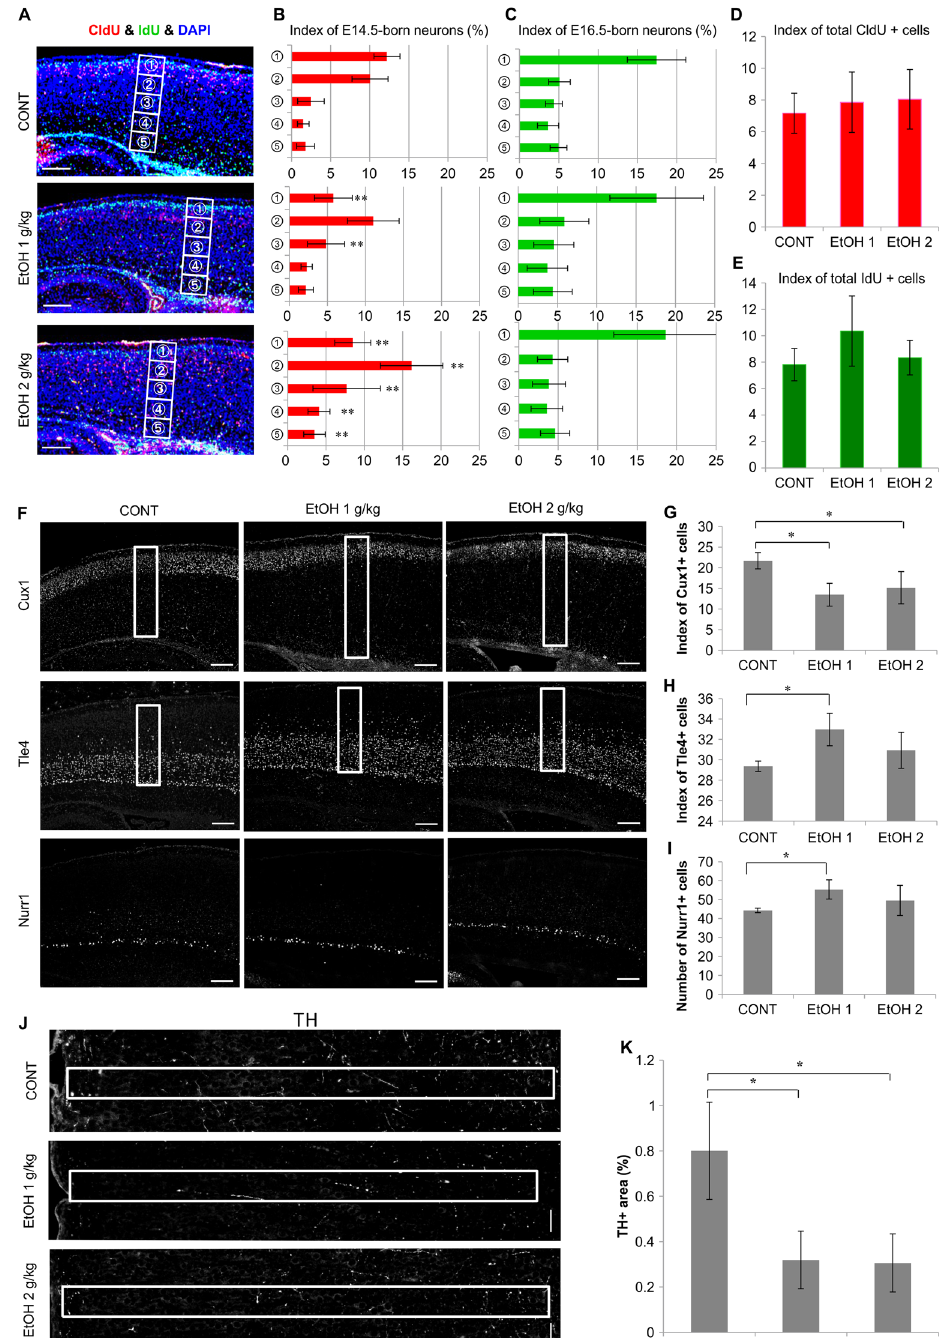
Figure 2. Impaired neocortical neuronal distribution, layer formation, and neuronal projection in newborn mice prenatally exposed to EtOH. ( A ) Images of birth-date analysis in parasagittal neocortical control (n = 6) and prenatal EtOH treated tissue sections (n = 6, respectively) at P3, using anti-CldU and IdU antibodies double staining after single pulse injections of CldU on E14.5 (red) and IdU on E16.5 (green). Scale bar, 100 µ m. ( B , C ) The ratio of CldU + ( B ) or IdU + cells ( C ) to the total number of cells (blue DAPI + cells) in ventral to dorsal bins (white boxes in A ) at P3. ( D , E ) The total number of CldU + E14.5-born ( D ) and IdU + E16.5-born neurons ( E ). ( F ) Immunostaining of P3 parasagittal neocortical sections with anti-Cux1 (layer 2/3), Tle4 (layer 4/5), and Nurr1 (layer 6b) antibodies. ( G – I ) The indice of neocortical Cux1 + ( G ), Tle4 + ( H ), and the number of Nurr1 + ( I ) neurons. Cells were counted in 100 µ m wide sampling boxes (white boxes in A and F ); scale bar, 100 µ m. (n = 6, respectively). ( J ) Images of P3 parasagittal neocortical sections immunostained with anti-tyrosine hydroxylase (TH) antibody, in which boxes indicate the measured area (from layer 1–6). (n = 6, respectively). ( K ) The percentage of neocortical TH + regions. Neurites were measured in 50 µ m wide sampling boxes (white boxes in J ); scale bar, 50 µ m, * P < 0.05, ** P < 0.01., compared to 0 mg∙kg − 1 controls using Dunnett’s test or Steel’s